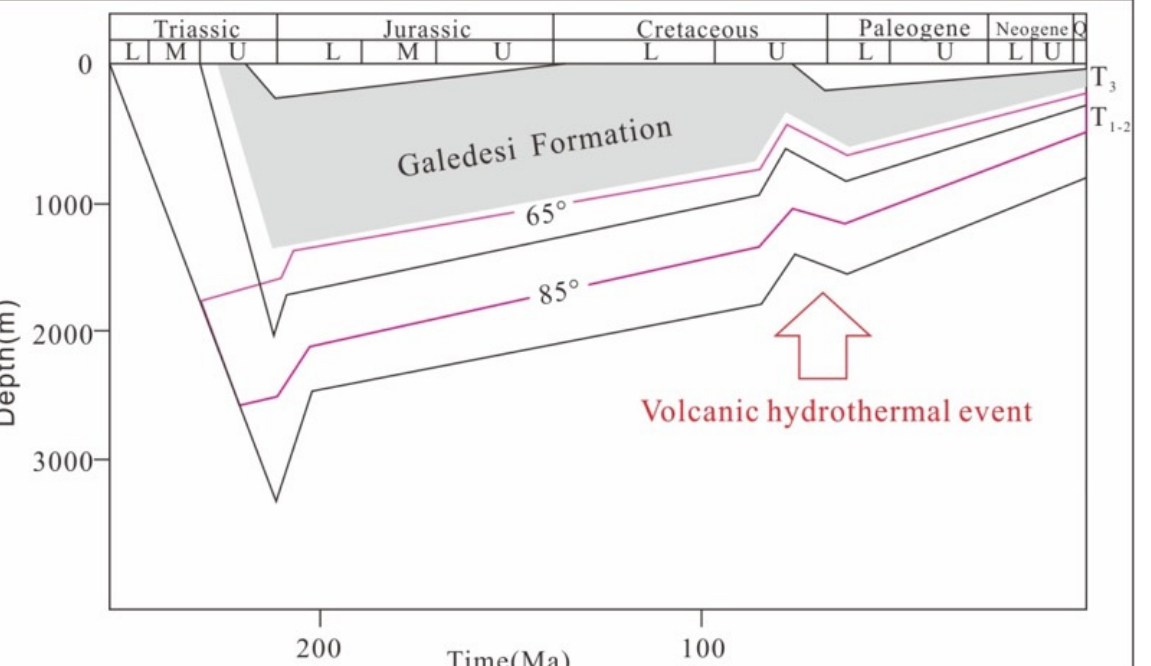
Figure 9. The model map of the magmatic thermal events in the study area.